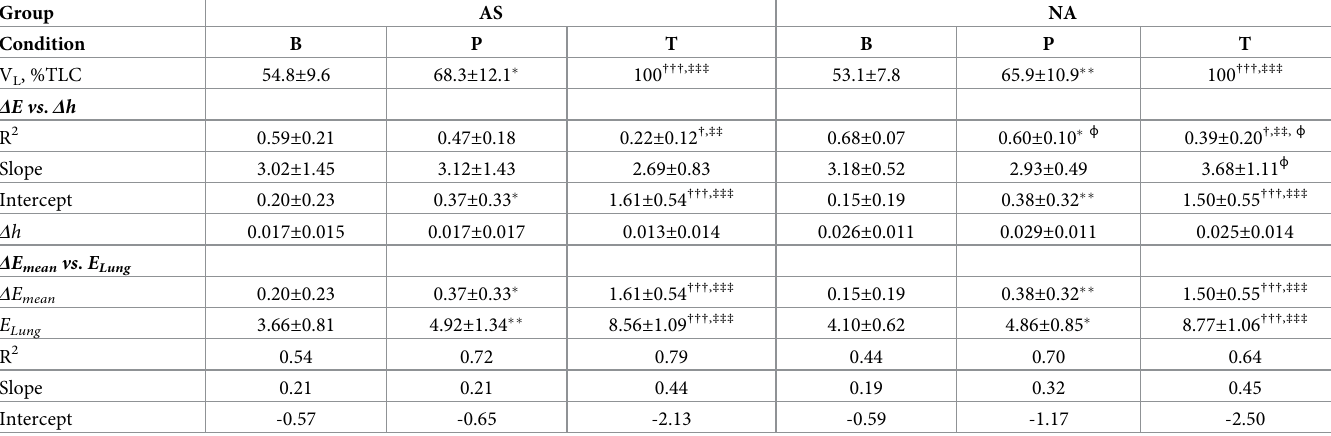
Table 2. Differences between peribronchial and segmental parenchymal expansion Δ E . Group AS NA